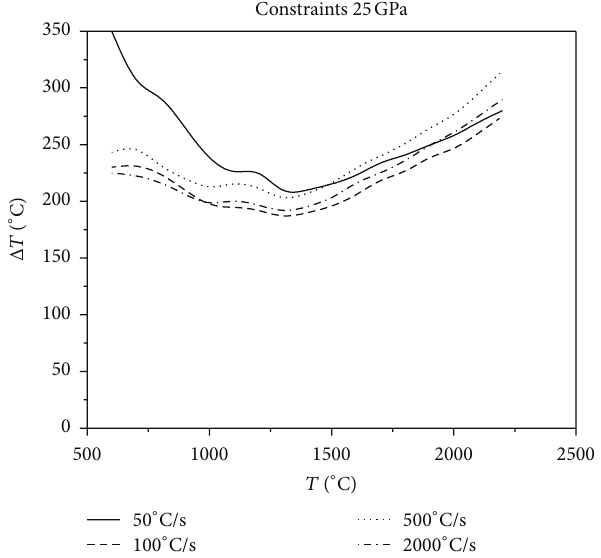
Figure 10: Relationship between critical fracture temperatures corresponding to different cooling rates and thermal shock initial temperatures under the constraints of 25GPa.